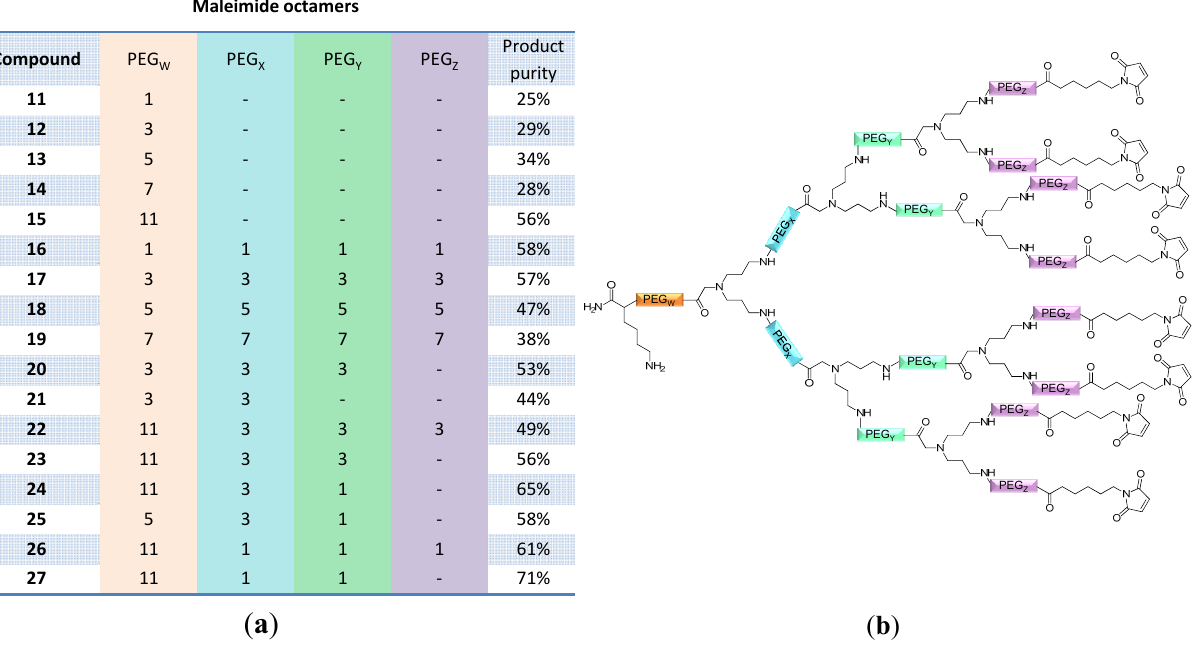
Figure 5. Analytical HPLC traces of the raw materials of octavalent maleimides synthesized comprising only one initial PEG position of the dendron ( 16 ,